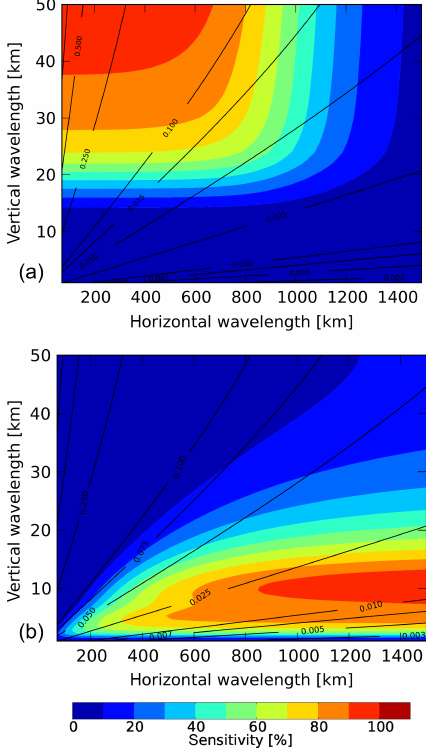
Figure 3. AIRS (a) and HIRDLS (b) observational filters indicate the sensitivity of temperature variances to gravity waves with dif- ferent horizontal and vertical wavelengths. The black lines show a momentum flux factor (see text for